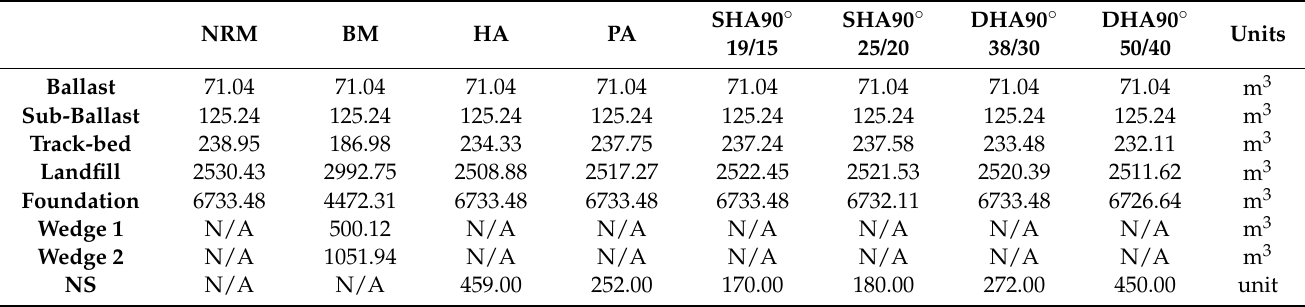
Table 2. Inventory of material inputs for each reinforcement arrangement.